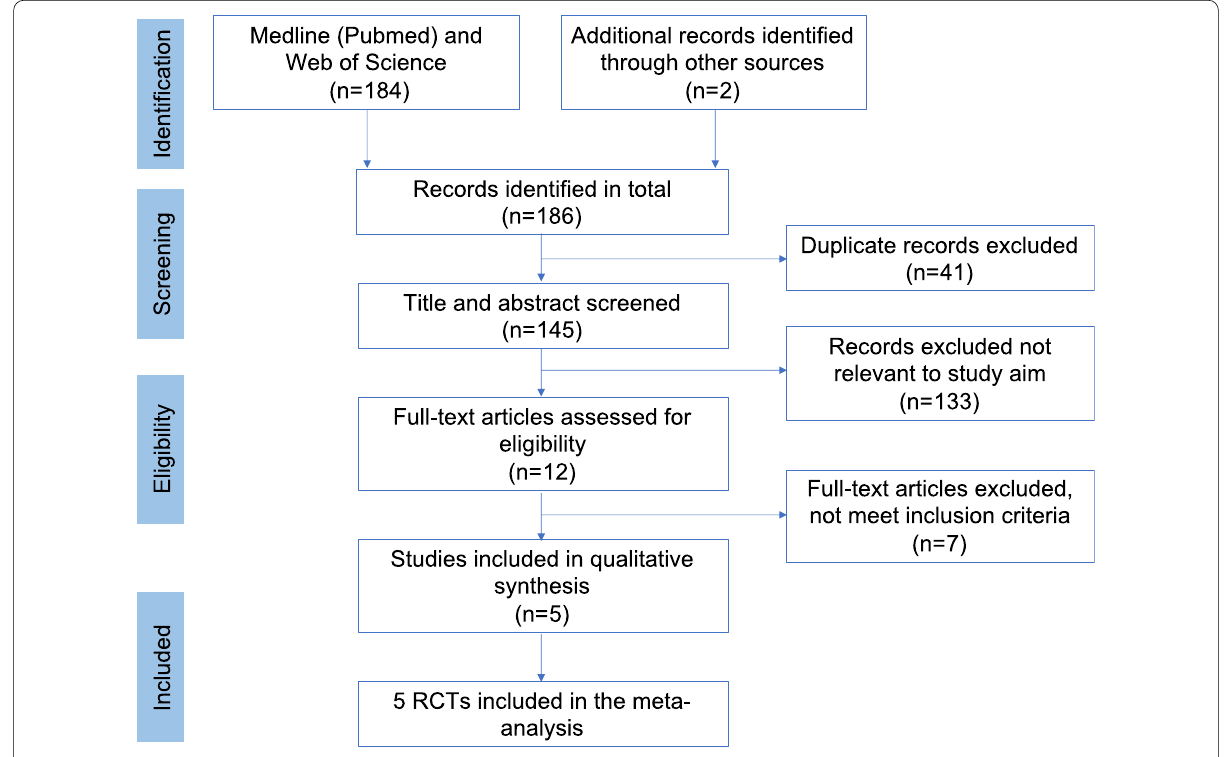
Fig. 1 Flow diagram of articles considered for